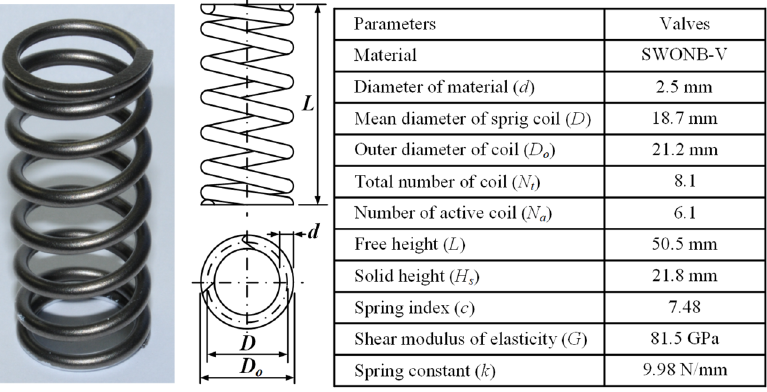
Figure 6. Dimensions of the automotive engine valve